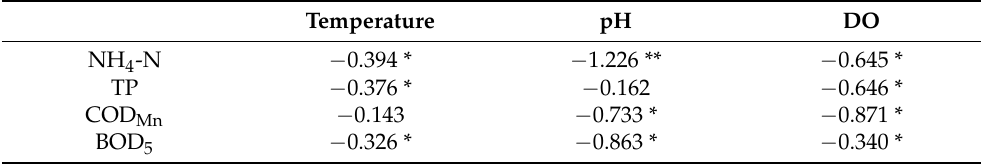
Table 3. Sensitivity coefficients of different water quality indicators to environmental factors.